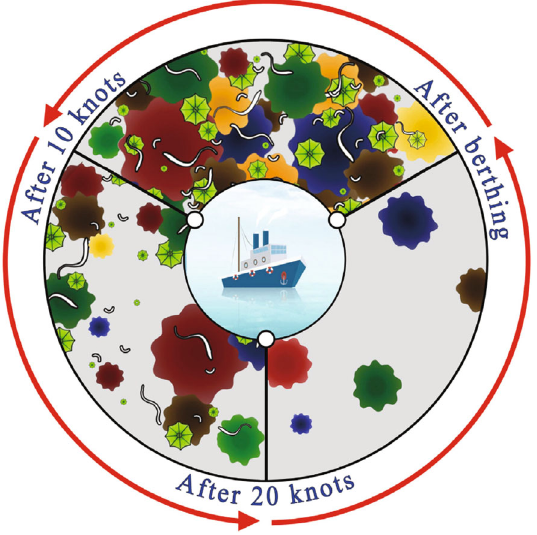
Figure 7: Self-cleaning schematic diagram of releasing descaling paint